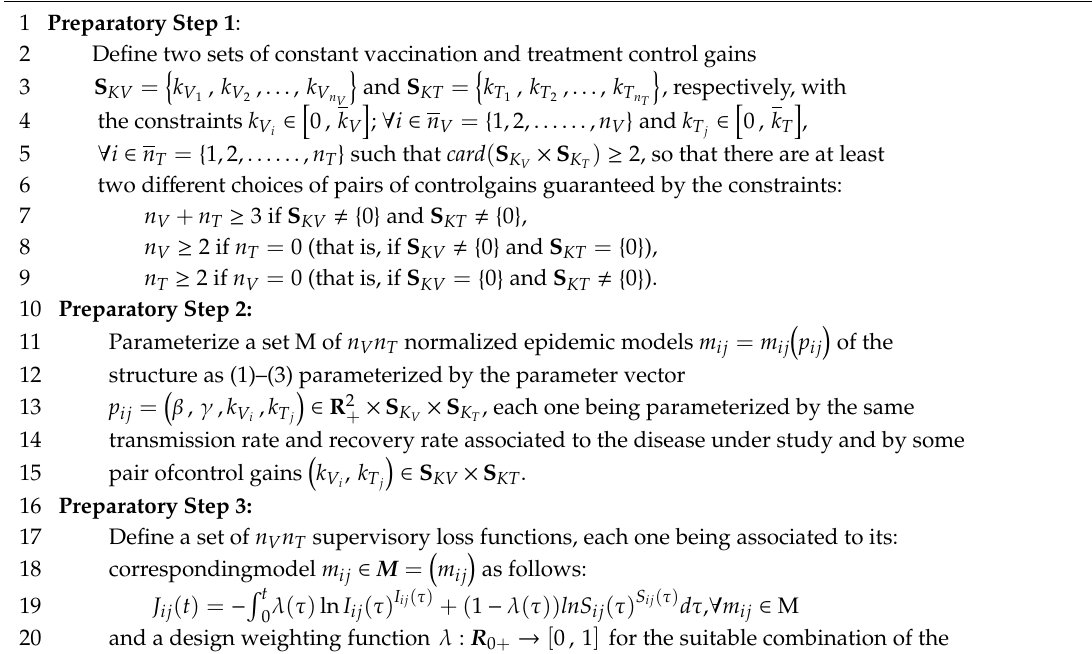
Algorithm 1 The whole set of control gains to update the active ones through time are fixed “a